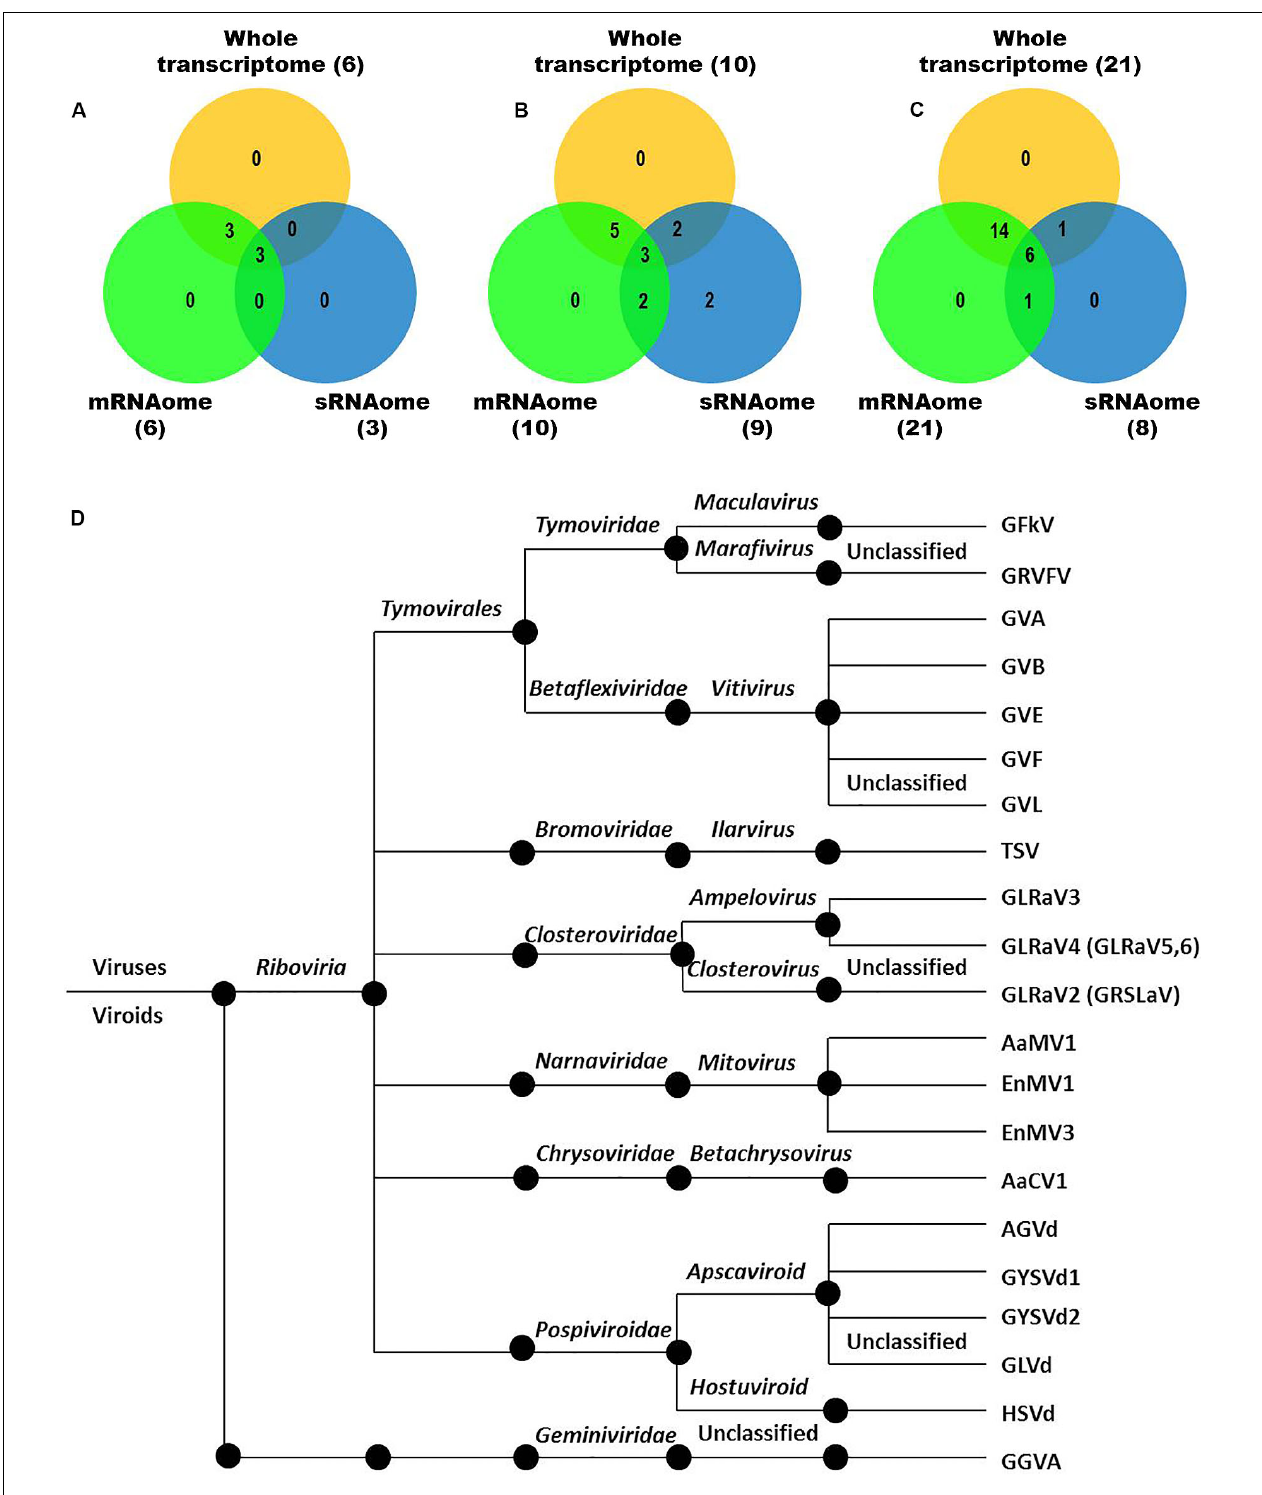
FIGURE 3 | Viruses and viroids identified in three Indian grapevine cultivars – BB, DK, RG. Venn diagram displaying viruses and viroids identified by any of the assemblers from combined mRNAomes, sRNAomes and whole transcriptomes in cultivars BB (A ), DK (B), and RG (C) . Blue, green, and yellow circles in the Venn diagrams represent the sRNAome, mRNAome, and whole transcriptome, respectively. Classification of the identified viruses and viroids is on the basis of taxonomy (D) .